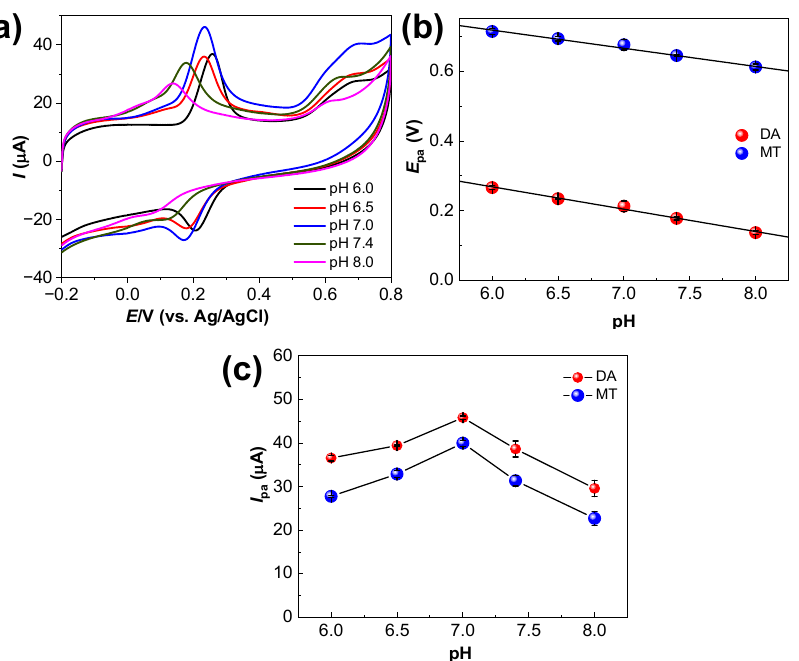
Figure 6. ( a ) CVs of Cu–CNS/SPCE in 0.1 M phosphate buffer solution (pH 7.0) containing 25 μM DA and 50 μM MT and the corresponding plots of ( b ) E pa values and ( c ) I pa values.